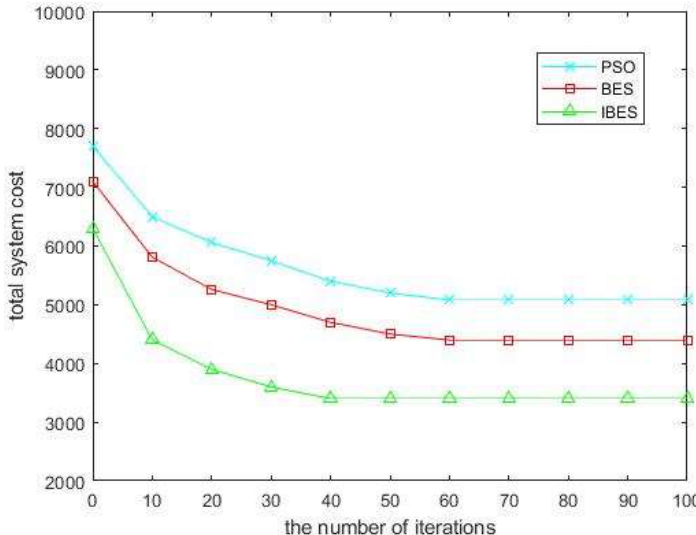
Figure 6. Comparison of total system cost under different iterations.